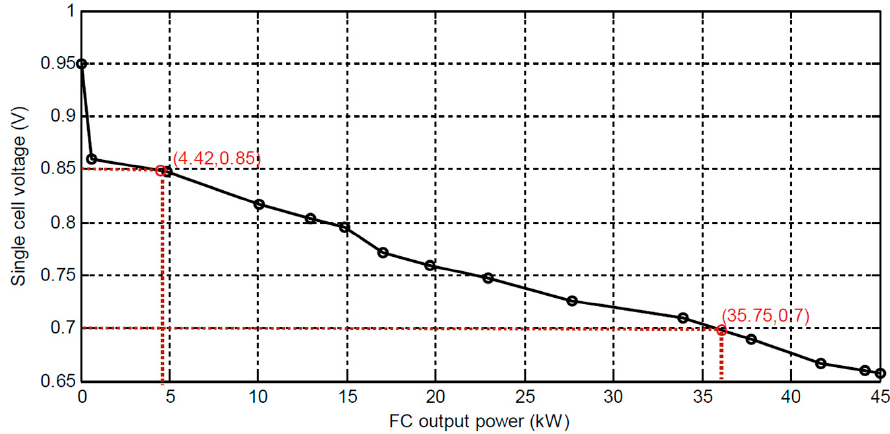
Figure 7. Fuel cell system output power and single cell voltage.